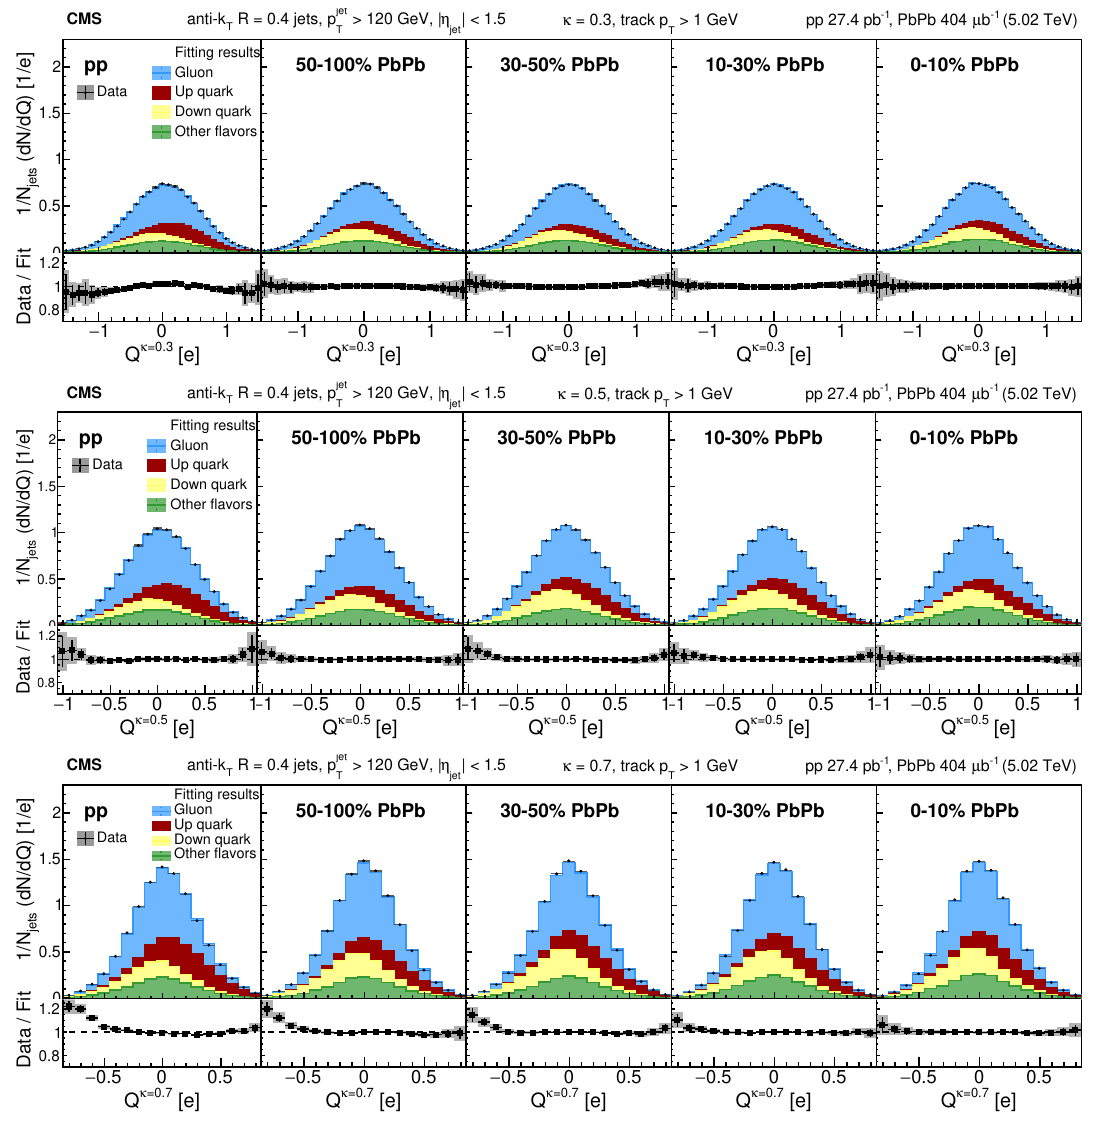
Figure 6 . (Upper row of each (cid:12)gure) Unfolded jet charge measurements shown for inclusive jets in data along with the extracted fractions of up, and down quark jets, gluon jets, and the \other (cid:13)avor" jets. The systematic and statistical uncertainties in the distributions are shown by the shaded regions and vertical bars, respectively. The jet charge measurements shown here are for a minimum track p of 1 GeV and a (cid:20) value of 0.3, 0.5, and 0.7 (top, middle, and bottom, respectively). T (Lower row of each (cid:12)gure) Ratio of the jet charge measurements to the results of template (cid:12)ts.